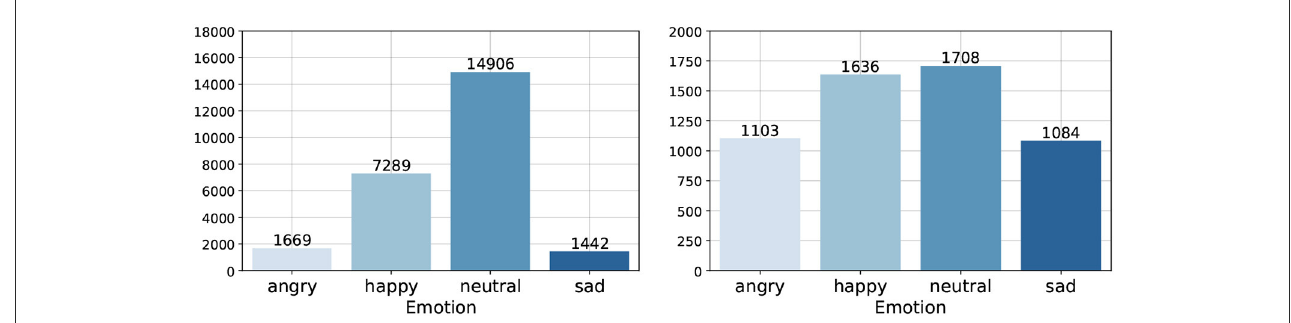
FIGURE2 Distribution of emotion categories for MSP-Podcast (left) and IEMOCAP (right) for the herein considered 4-class classification problem using the {angry, happy, neutral, sad} categories. For IEMOCAP, “excited” samples are fused with “happy” ones.